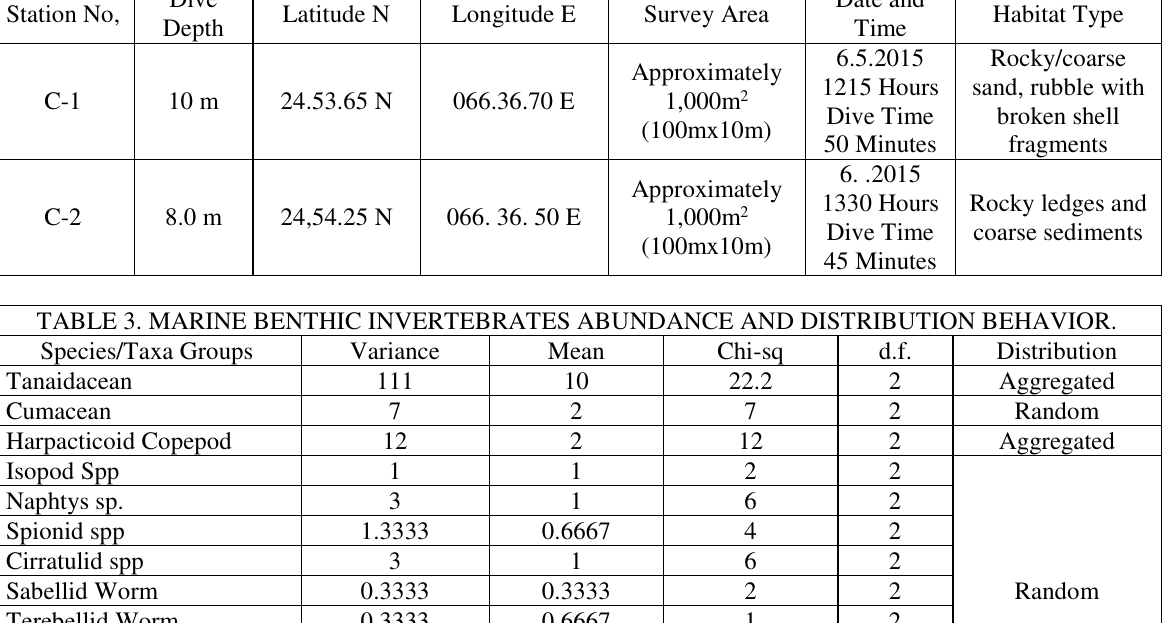
TABLE 2. CORAL SAMPLING LOCATIONS AT CHURNA